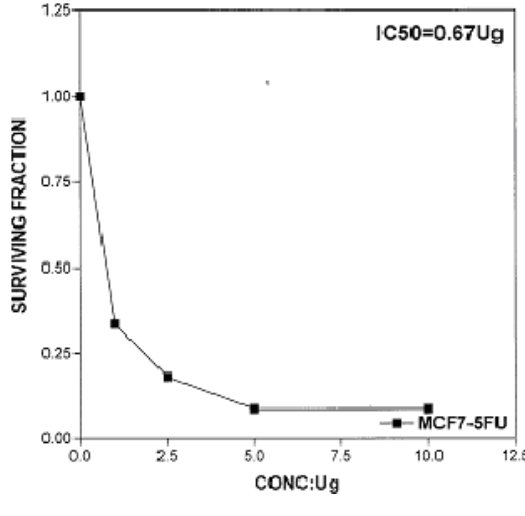
Figure 6. Effect of conc. of 5-fluorouracil (standard) on MCF-7